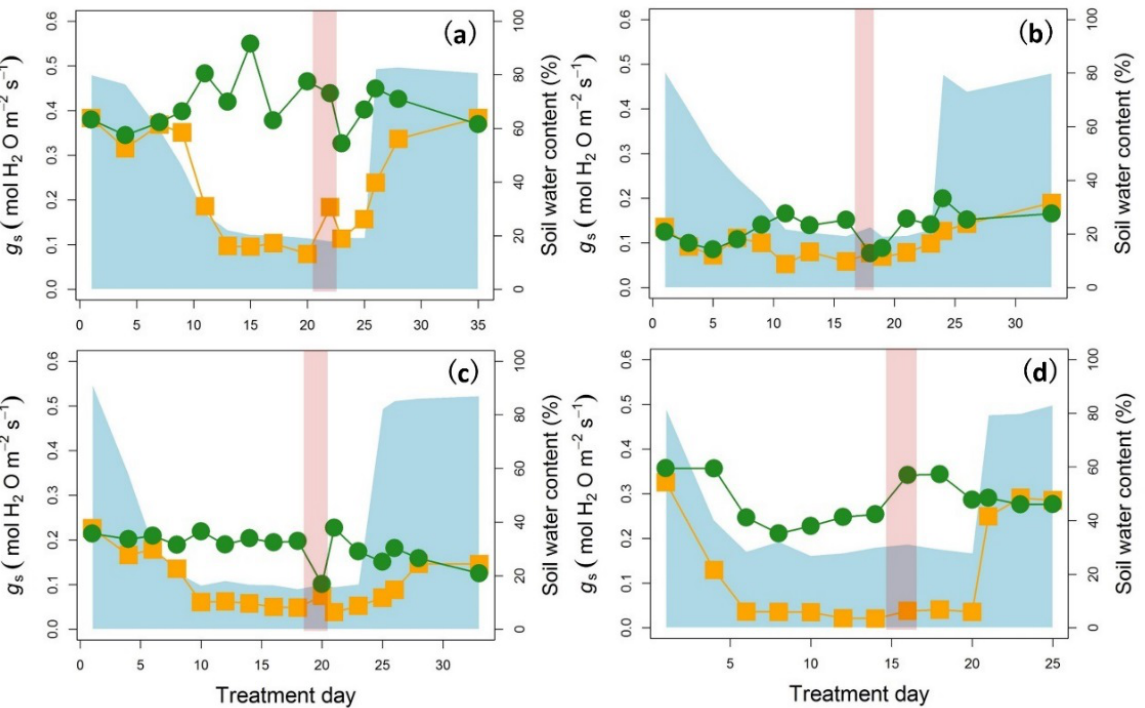
Figure 8. Time courses of stomatal conductance ( g s ) and soil water content for wheat ( a ), sorghum ( b ), F. chinensis ( c ) and R. sinica ( d ). Green circles represent plants always under well-watered conditions. Data show the mean of four replicates (n = 4). Orange squares represent plants subjected to drought treatment. The blue shaded area indicates the soil water content and the pink shaded area indicates the 2-day heat stress, in which both day and night temperatures were increased by 15 °C.